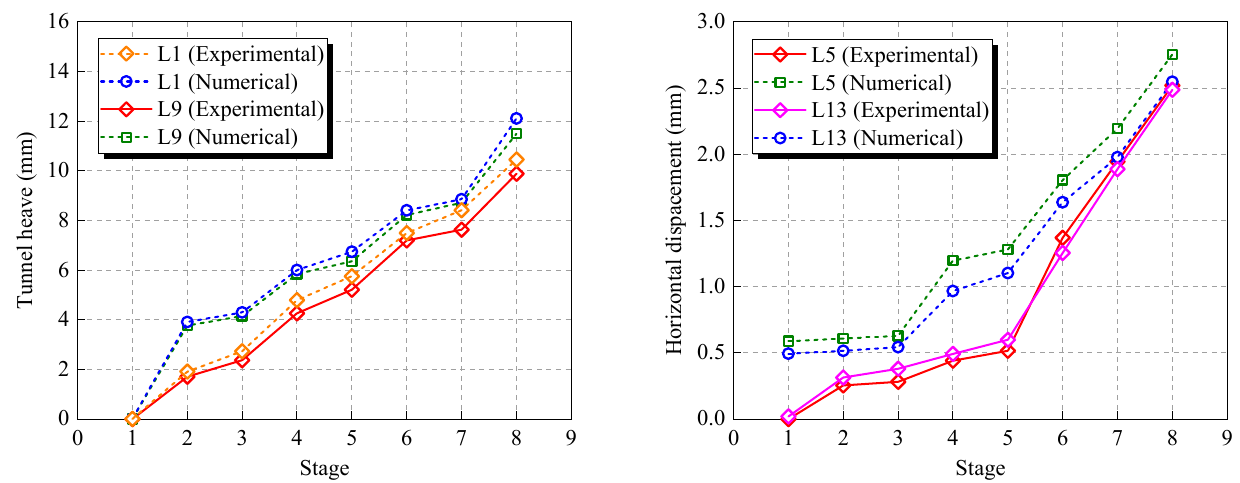
Figure 14. Comparison of tunnel displacements between numerical simulation and experimental test.